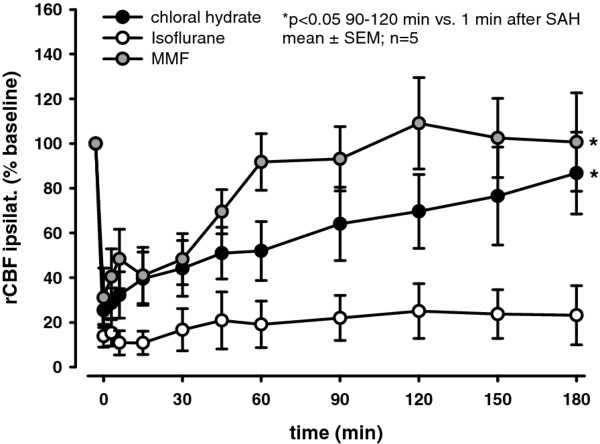
Regional cerebral blood flow of the hemisphere ipsilateral to hemorrhage measured by laser Doppler fluxmetry until 180 minutes after SAH. SAH resulted in an immediate reduction of rCBF in all groups with a significantly better recovery in the MMF group (*p < 0.05 vs. isoflurane). rCBF was recorded continuously, averaged over 3 minutes, and displayed as percentage (%) of pre-hemorrhagic baseline (means ± SEM; n = 5 in each group; Kruskal-Wallis ANOVA on ranks followed by Dunn's post-hoc test).